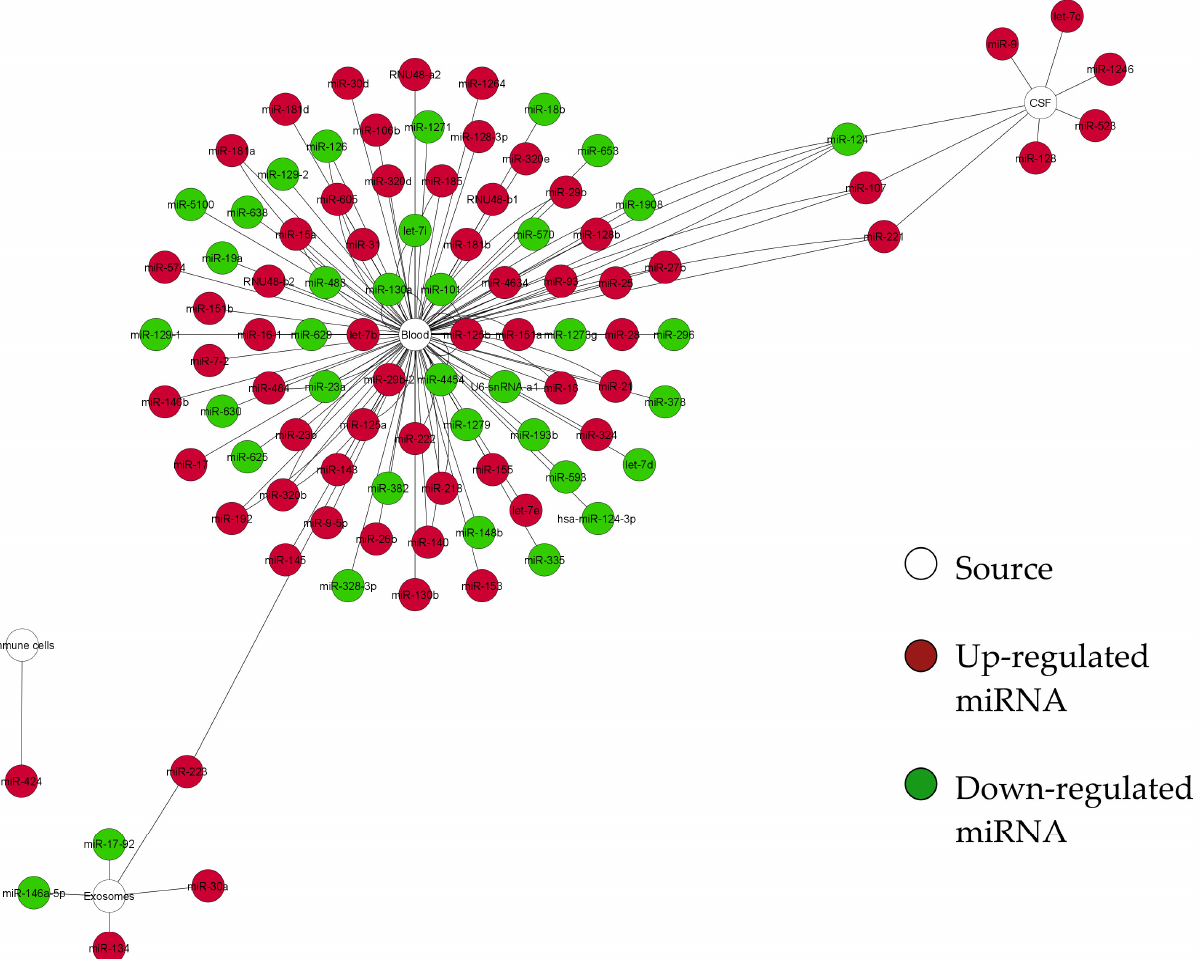
Figure 2. Structural network of the DE miRNAs derived from AIS patients according to the sample origin. The network represents miRNAs (nodes green or red) organized according to the source (white nodes) from which the samples were derived (Table S1). miRNAs appear as nodes colored in red (upregulated) or green (downregulated) according to their expression; edges indicate the number of independent studies reporting them. Four miRNAs are common in at least two different tissues (miR-124, miR-107, miR-221, and miR-223). Number of nodes: 103, number of edges: 133, network diameter: 6, network centralization: 0.887. The network was built using Cytoscape software (v.3.8.0). For a better image resolution, please review the Supplementary Materials (Figure